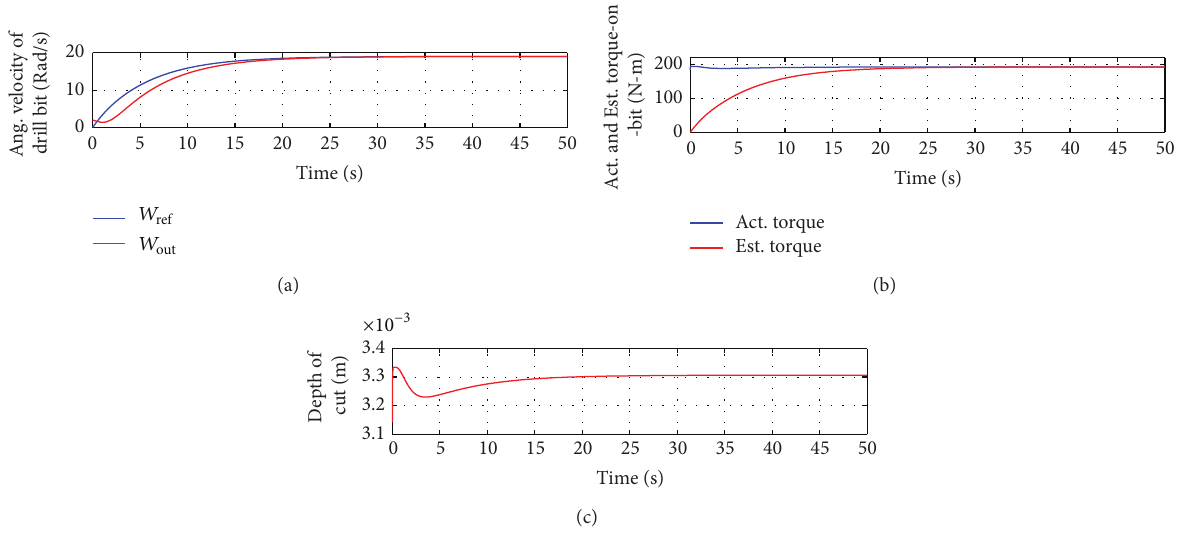
̂𝑇(𝑡) (b), and the depth of cut 𝑑(𝑡) (c)